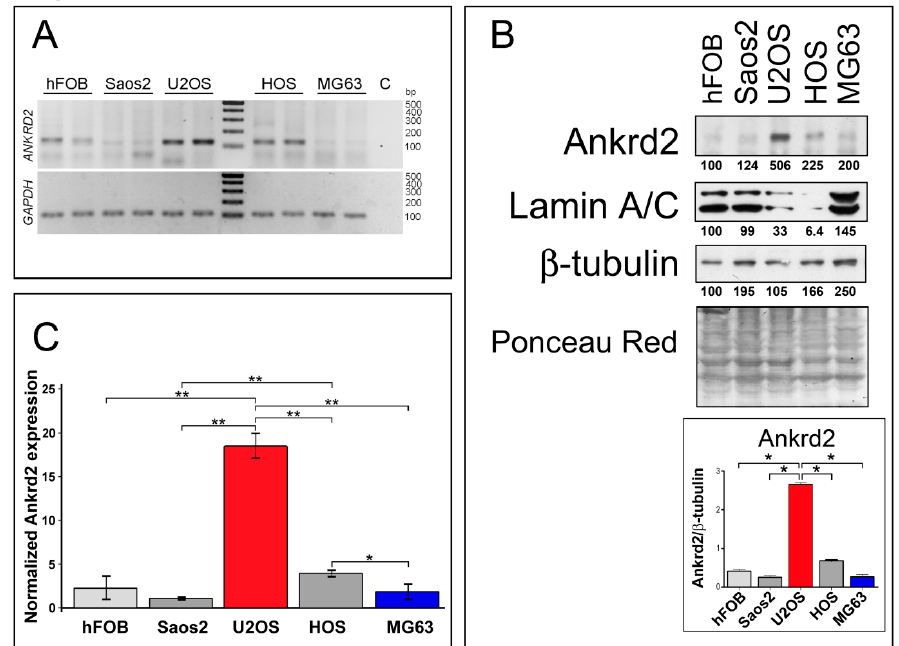
Figure 1. Ankrd2 is expressed in cell lines derived from human osteosarcoma and human normal osteoblasts. ( A ) Detection of the ANKRD2 transcript in cell lines obtained from human normal osteoblasts (hFOB) and from human osteosarcoma (Saos2, U2OS, HOS and MG63). The fragment was amplified by RT-PCR using cDNA from at least three passages of tumor cells. Housekeeping GAPDH was used as a quality control. No cDNA was added to the control reaction ( C ). Length of the amplicons are presented in Table S1. ( B ) Total cell lysates from hFOB, Saos2, U2OS, HOS and MG63 were resolved by SDS-PAGE and assayed for Ankrd2 expression. A positive signal was ob- served at 38 kDa corresponding to the expected molecular weight. Levels of lamin A/C were also determined. β -tubulin and ponceau-red staining of the filter were used as equal loading controls. Expression of Ankrd2 is presented as the ratio between the values of densitometric analysis of the bands of anti-Ankrd2 against those of anti- β -tubulin. Blots are representatives of four repetition. ( C ) Relative quantification of ANKRD2 mRNA expression in hFOB, Saos2, U2OS, HOS and MG63 cell lines as determined by qPCR. GAPDH served as the internal reference. The data are expressed as 2 − Ct × 10 5 and presented as mean ± SD of at least three biological replicates. Statistical analysis was performed with a paired two-tail Student’s t -test. * p < 0.01, ** p < 0.001. Average Ct ± SD values are presented in Table S2. 3.2. Characterization of Clones of OS Cell Lines Stably Expressing wt and S99A Ankrd2 To evaluate the involvement of Ankrd2 in OS progression, Saos2, U2OS, HOS and MG63 OS cell lines and control hFOB cells were stably transfected with an expression vector encoding Flag-tagged Ankrd2wt (Flag-Ankrd2wt). Moreover, since in C2C12 my- oblasts most of the cellular functions of Ankrd2 are mediated by its phosphorylation on S99 by Akt2 [10,11], and since Akt2 plays a key role in the progression of several types of cancer including OS [20], we were also interested in determining if S99 might be involved in oncogenesis of OS. For these reasons, cells were also transfected with a mutant form of Flag-tagged Ankrd2, which cannot be phosphorylated on S99, Ankrd2(S99A) (Flag- Ankrd2(S99A). The results in Figure 2A demonstrate that both Ankrd2 forms (wt and S99A) were expressed in all cell lines. Using a custom made phospho-specific antibody, the level of Ankrd2 phosphorylated on S99 was also analyzed. Figure 2A shows that in U2OS and Saos2 clones, ectopic Flag-Ankrd2wt was phosphorylated, whereas the phos- phorylation control Flag-Ankrd2(S99A) was not. In hFOB, HOS and MG63 clones, phos- phorylation of Flag-Ankrd2wt on S99 was not detected (Figure 2A). To test the hypothesis that the lack of Ankrd2 phosphorylation on S99 in hFOB, HOS and MG63 clones express-